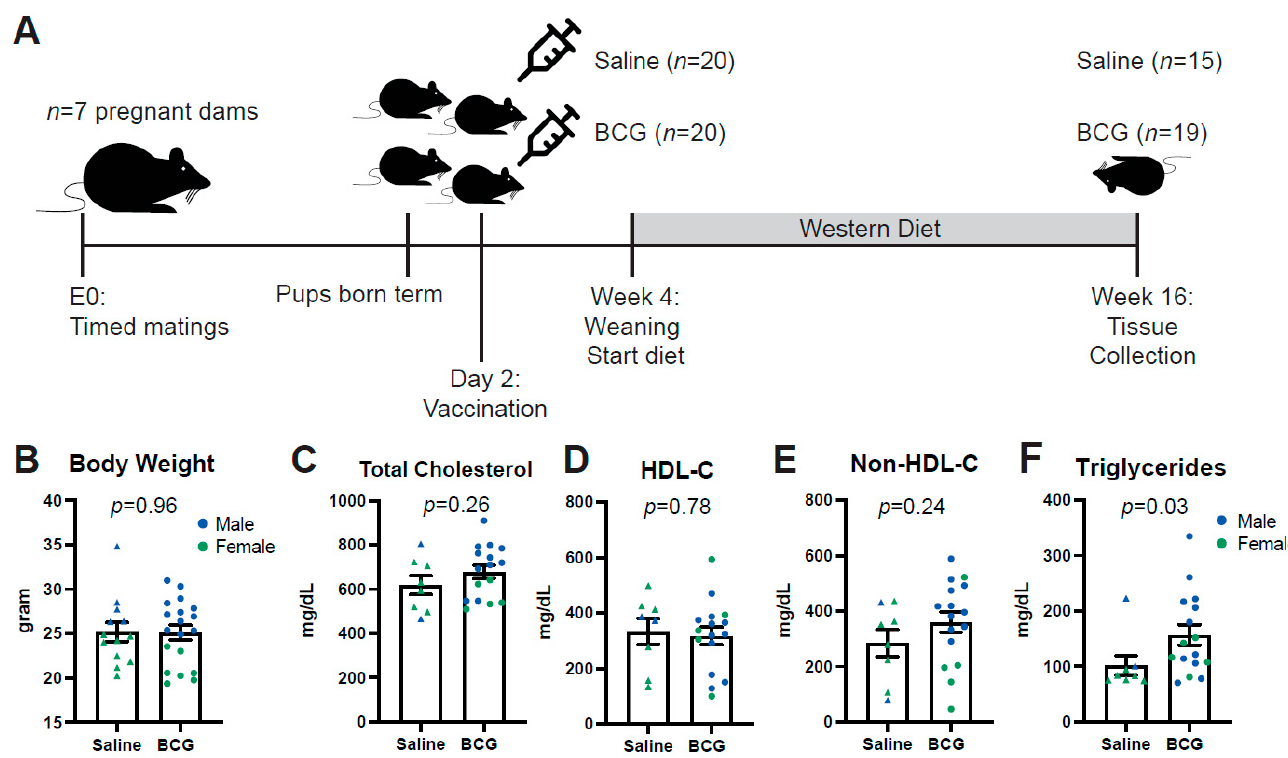
Figure 1. Study design and baseline characteristics. ( A ) Design of the study. 40 pups were randomly assigned to subcutaneous BCG or Saline injection at postnatal day 2. In week 4, mice were fed a Western diet for 12 weeks until tissue collection at week 16. ( B ) Body weight of the mice at week 16 did not differ between BCG or Saline treated mice; n = 15 for Saline (depicted as triangles) and n = 19 for BCG (depicted as circles). Male mice are depicted in blue, female mice in green. ( C ) Total plasma cholesterol, ( D ) HDL and ( E ) Non-HDL-C at week 16 were all similar between groups. ( F ) triglycerides were significantly higher in BCG-treated mice; n = 9 for Saline and n = 15 for BCG.